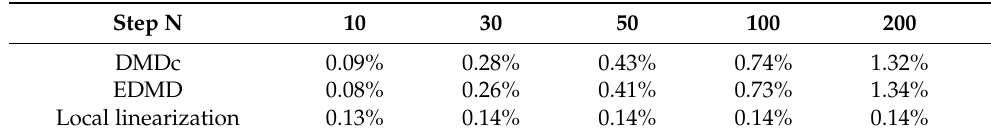
Table 3. RMSEs of deviations between the real states and the predicted states with different methods (Scenario 1).